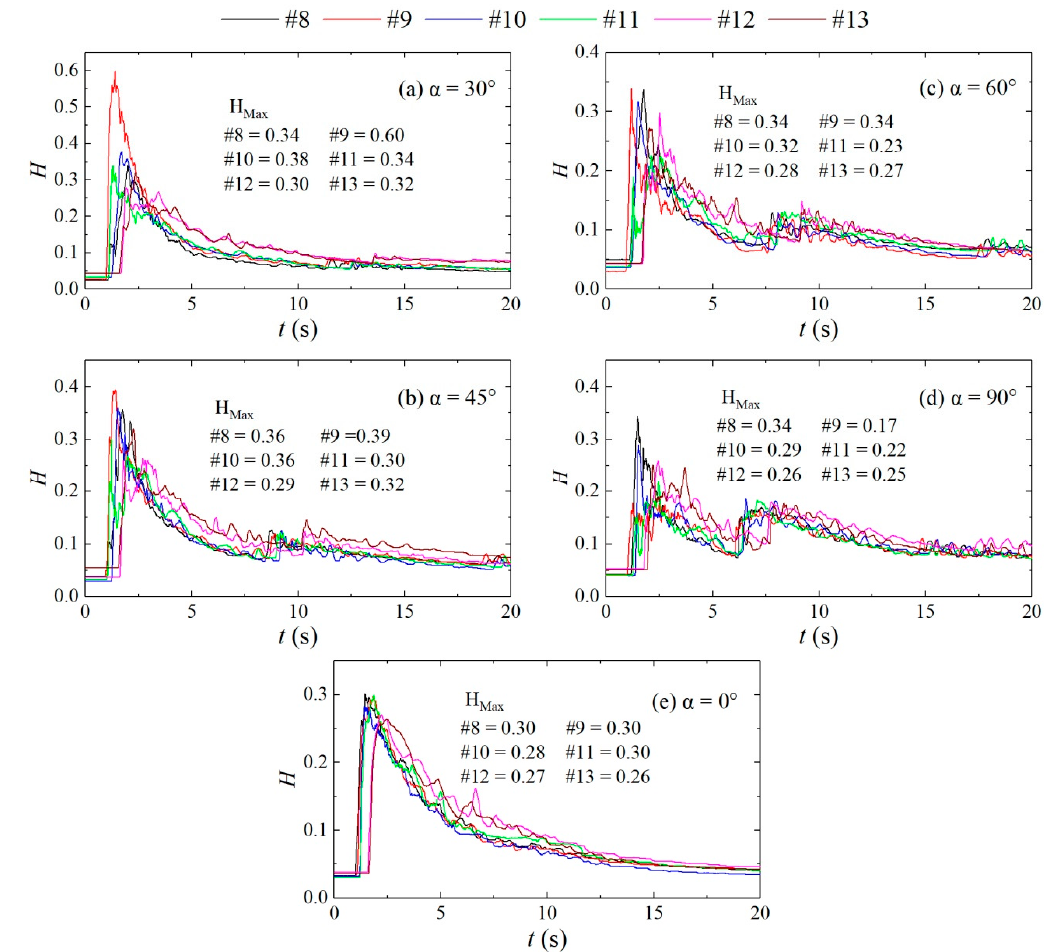
Figure 8. Variations in the water depths of the downstream straight sections of different configurations with time. ( a ): α = 30 ° ; ( b ): α = 45 ° ; ( c ): α = 60 ° ; ( d ): α = 90 ° ; ( e ): α = 0 ° .